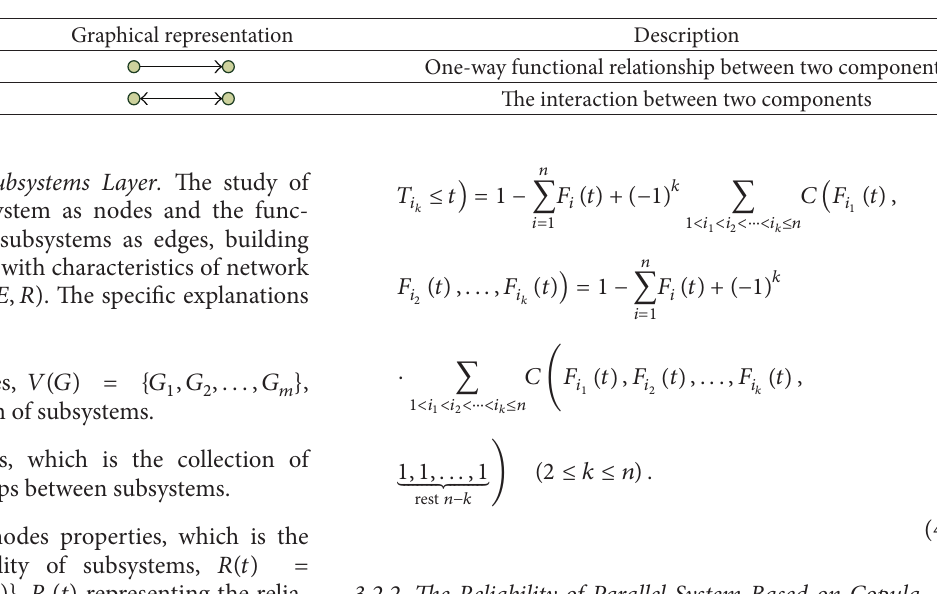
Table 1: The way of connection between the components and its formalized